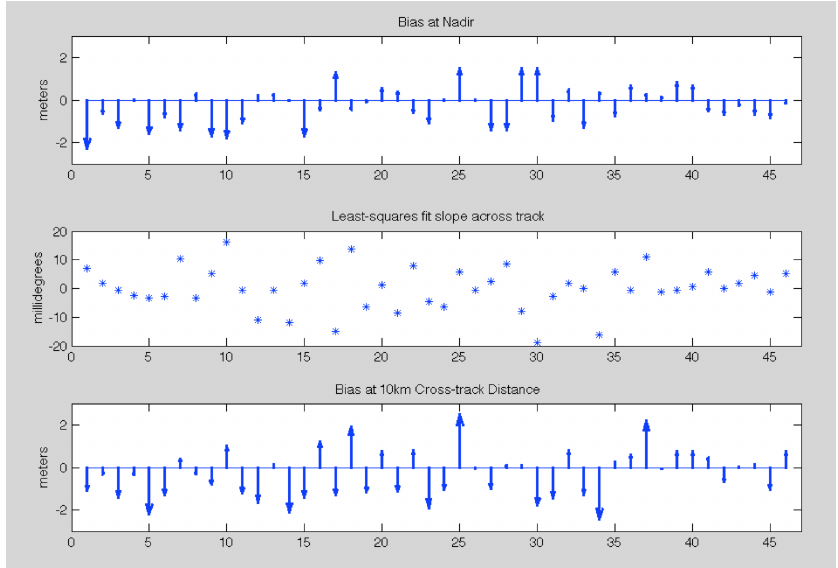
Figure 8. Validation results for the 2016 GLISTIN-A acquisitions. The upper plot shows the mean bias of the GLISTIN-A data when compared with ATM projected to nadir. The middle plot shows the corresponding least squares cross-track slope in millidegrees. The final plot shows the mean height bias of the GLISTIN-A data at 10 km cross-track distance (8 km swath). The dashed lines in the upper and lower plots correspond to the OMG accuracy requirements. Table A1 itemizes this information with cross reference to the flight line identifiers (in the same order as this plot).